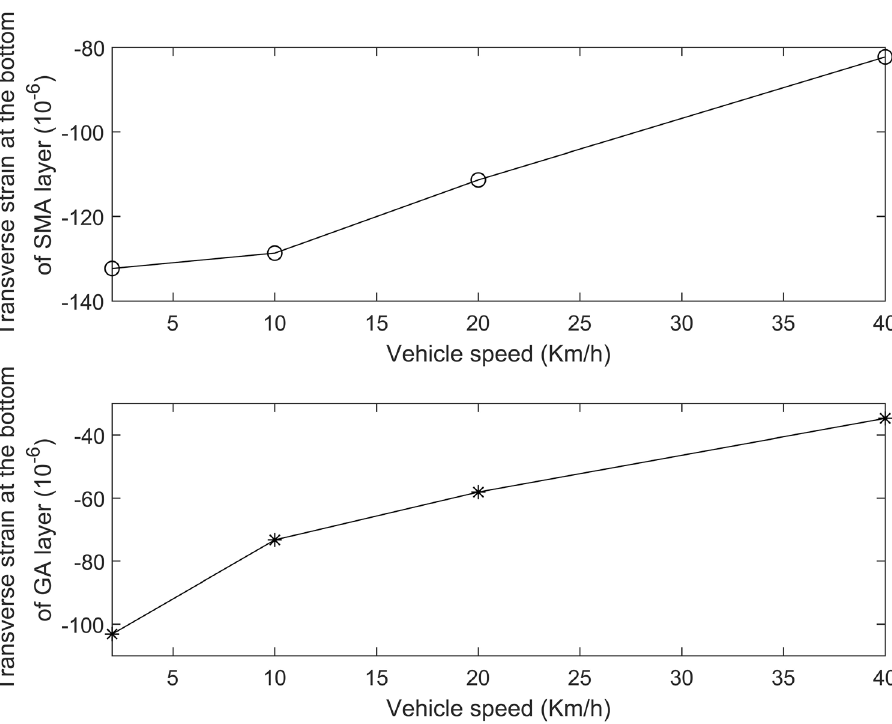
Figure 8. Transverse strain of the deck pavement under different vehicle